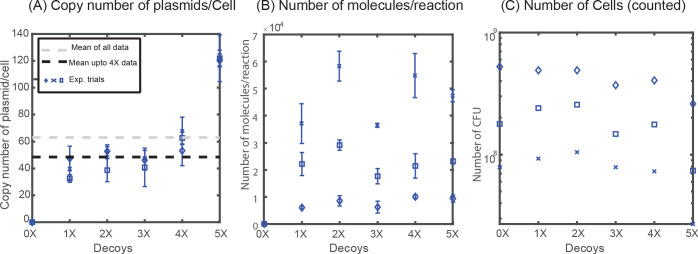
Quantification of plasmid copy number.(A) Copy number of decoy array plasmids measured in M9-Glucose minimal media. (B) Number of molecules obtained per qPCR reaction remains constant across different decoy strains (1X, 2X, 3X, 4X, 5X). (C) Number of Colony Forming Units (CFU) per mL used to normalize the number of molecules to account for the copy number of plasmids per cell.